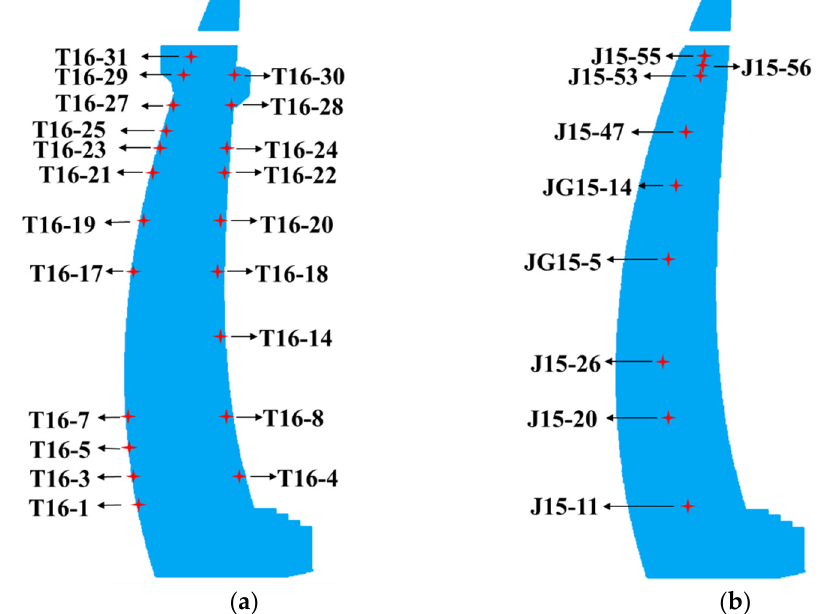
Figure 2. Schematic diagram of the location of temperature monitoring points. ( a ) Thermometers of No.16 dam section; ( b ) joint meters of No.15 dam section. Table 2. The elevation of the temperature monitoring points.